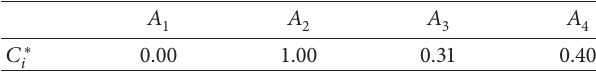
Table 21: The relative closeness